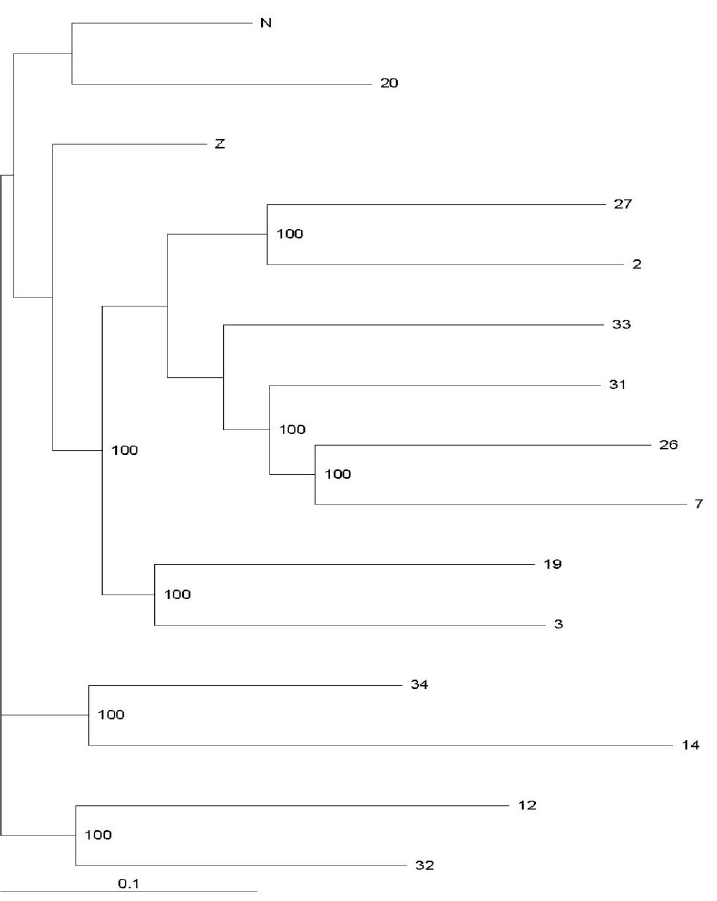
Figure 3. Phylogenetic analysis of the P. trituberculatus collected from 13 sites of Yangtze Estuary and 2 hatcheries located in Nantong (N) and Zhoushan (Z).